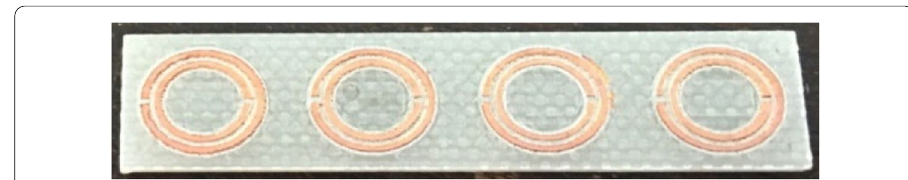
Fig. 10 Fabricated single layer of metamaterial with four SRRs metamaterial